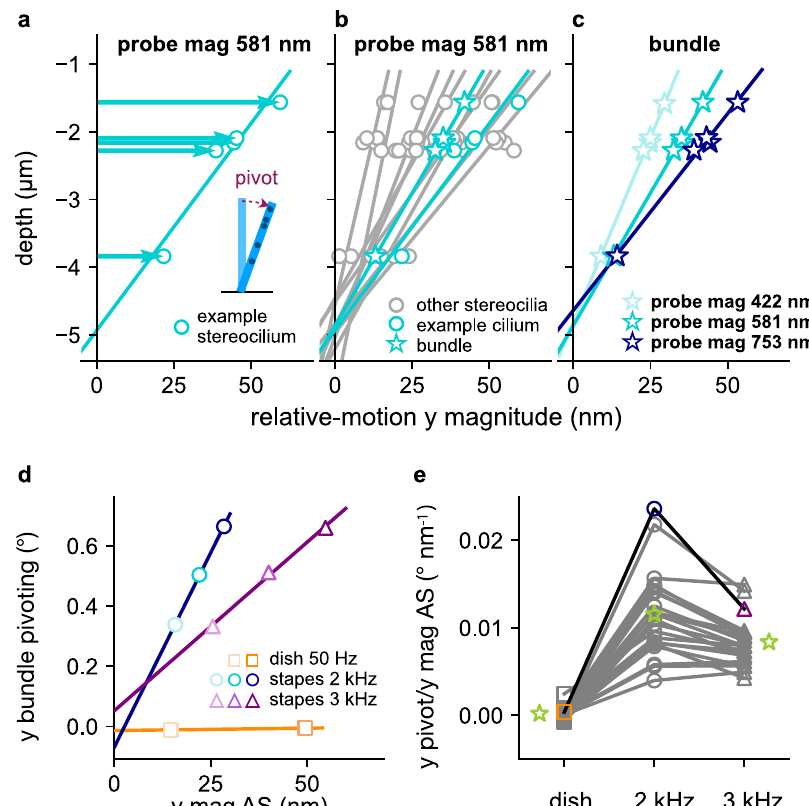
Fig. 5 Rigid-rod-like pivoting of individual stereocilia and bundle pivoting. a – c The pivoting results are shown for 2-kHz-stapes stimulations. Note that the scales of the horizontal and vertical axes are different. a The radial ( y ) relative-motion magnitudes at different depths (circles) are shown for an example stereocilium, with a best- fi t line shown to indicate the stereocilium. The horizontal arrows emphasize the greater magnitude of the stereocilium motion as one moves away from the pivoting point toward the tip. The inset shows a cartoon illustration of a stereocilium pivoting. b The results from a are replicated and shown alongside the results from the other individual stereocilia in the bundle (gray circles and lines), and the average for the whole bundle (stars), all from the same measurement and therefore with the same input level. c The radial ( y ) relative-motion results for the whole bundle (averaged across stereocilia) are shown for three different input levels. d The radial bundle pivoting angles are plotted against the radial AS magnitude for the example bundle. e The radial pivoting angle, normalized by the radial AS magnitude, is compared among the three stimulation conditions for all bundles, with the green stars representing the average value of each